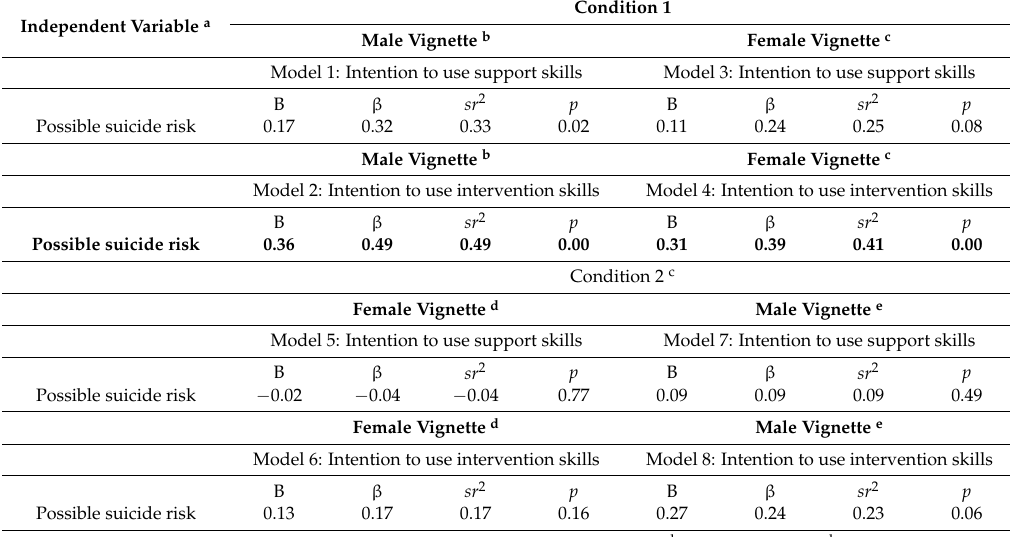
Table 4. Results of multivariate regression models examining the association between TCWs’ rating of callers’ potential for suicide risk and their intention to use support or intervention skills with male and female